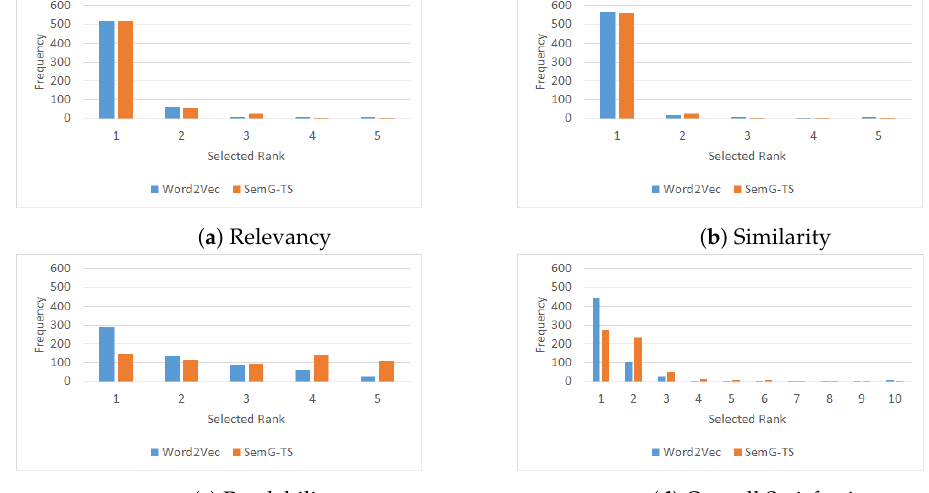
Figure 7. The frequencies of the evaluators’